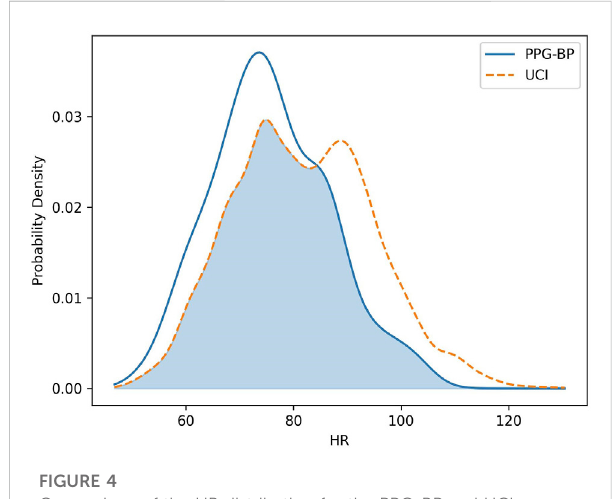
FIGURE 5 Comparison of the DBP distribution of the PPG-BP and UCI